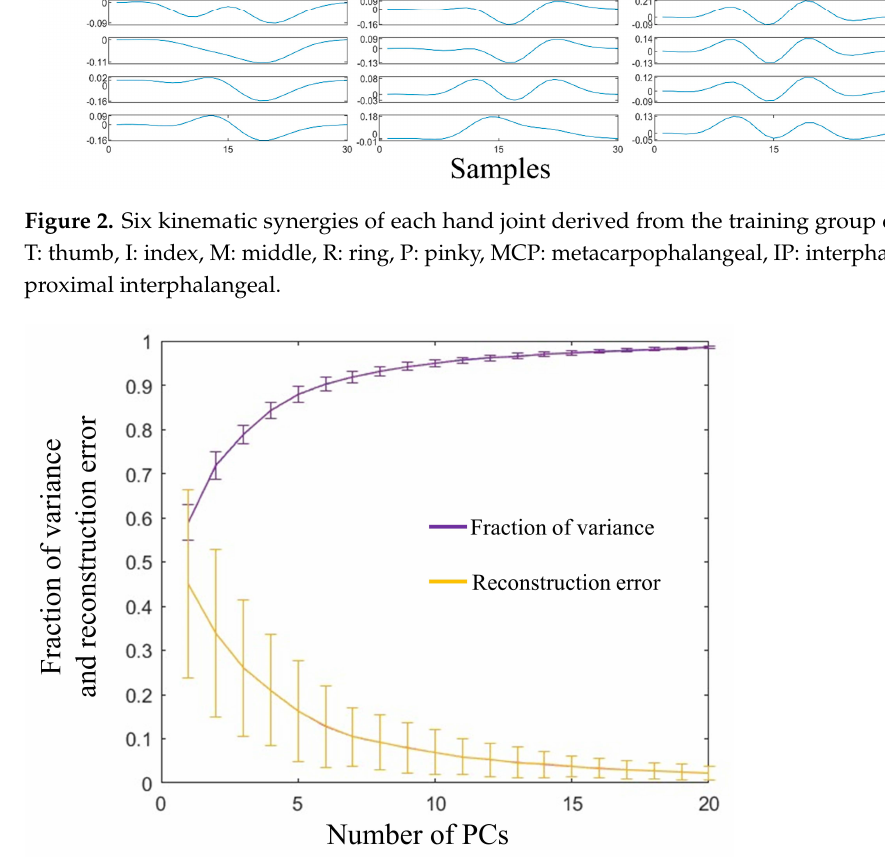
Figure 3. Fraction of variance of PCs and reconstruction error using different numbers of